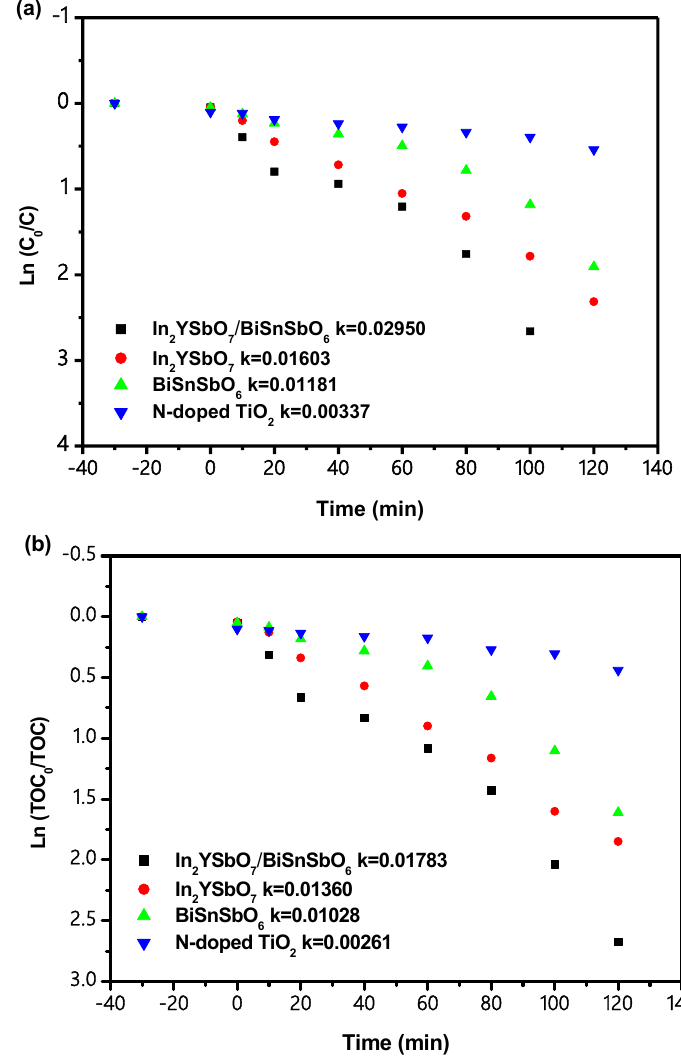
Figure 20. ( a ) Observed FOK plots for the PCD of IC with IBH or In 2 YSbO 7 or BiSnSbO 6 or N-TiO 2 as photocatalyst under VLGI. ( b ) Observed FOK plots for TOC during PCD of IC in DW with IBH or In 2 YSbO 7 or BiSnSbO 6 or N-TiO 2 as photocatalyst under VLGI. Figure 21 shows the FOK for the PCD of IC when IBH is used as a catalyst for TCDT under VLGI conditions. According to the results shown in Figure 21, the KCK derived from the DCT IC concentration and VLGI time with IBHP for TCDT achieved 0.02602 min − 1 , 0.02119 min − 1 and 0.01877 min − 1 . In addition, the KCK which came from the DCT TOC concentration and VLGI time with IBH as a photocatalyst for TCDT reached 0.01717 min − 1 , 0.01569 min − 1 and 0.01491 min − 1 . The results of the analysis are shown in Figures 20 and 21; the PCD of IC in DW with IBH as a photocatalyst under VLGI conformed to first-order reaction